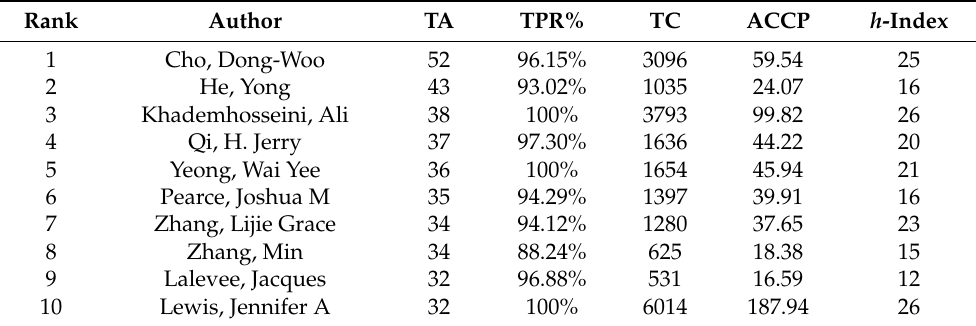
Table 5. Contribution of the top 10